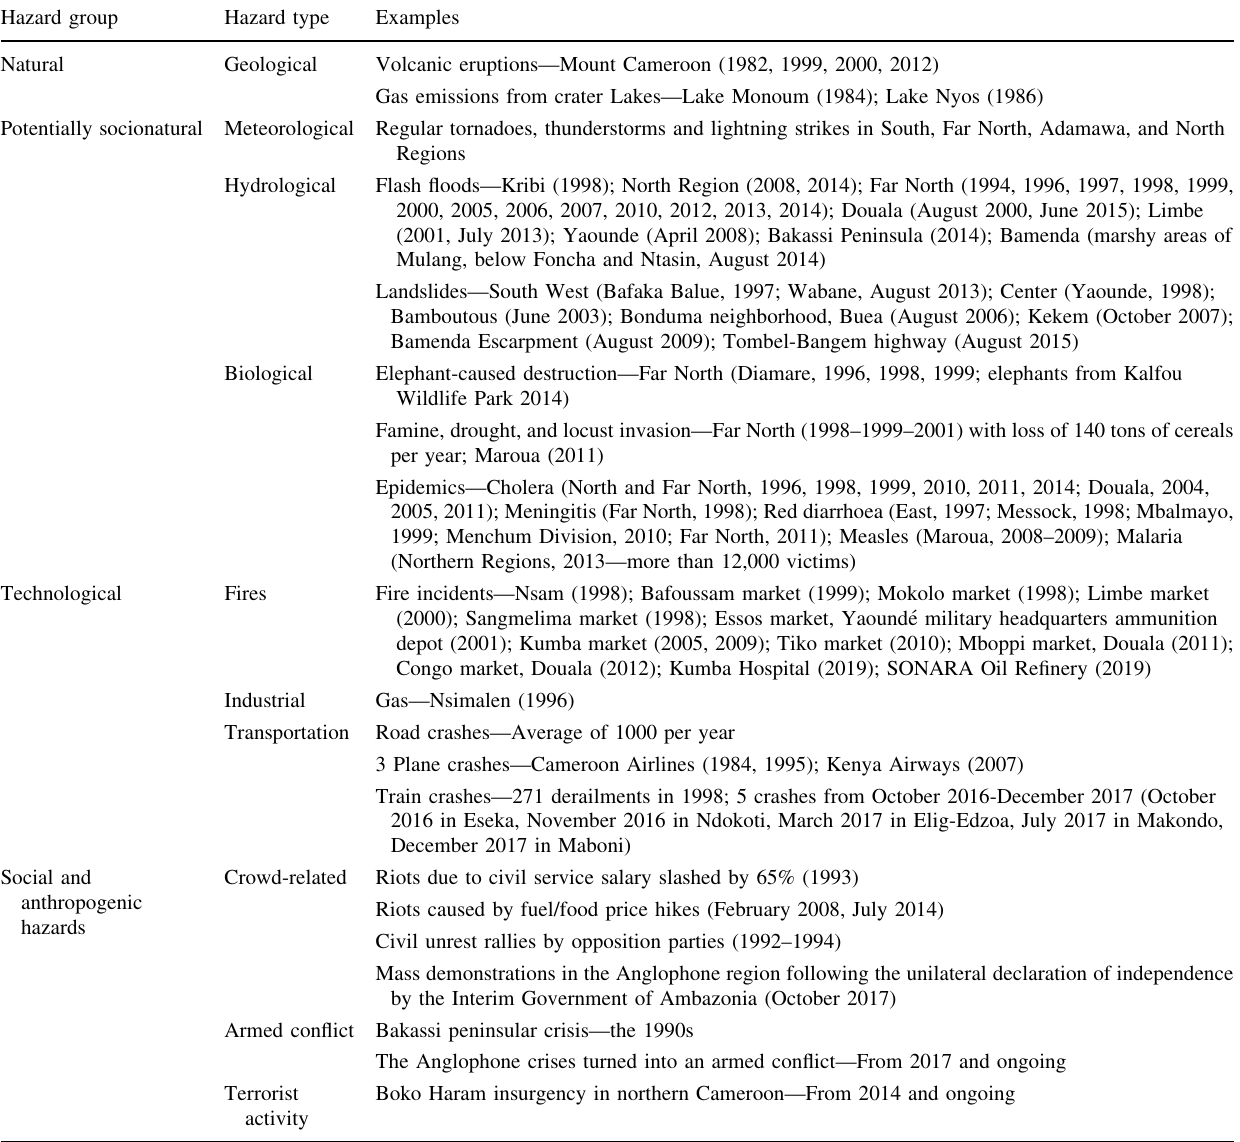
Table 1 Different hazard groups/types in Cameroon with some examples from 1980 to